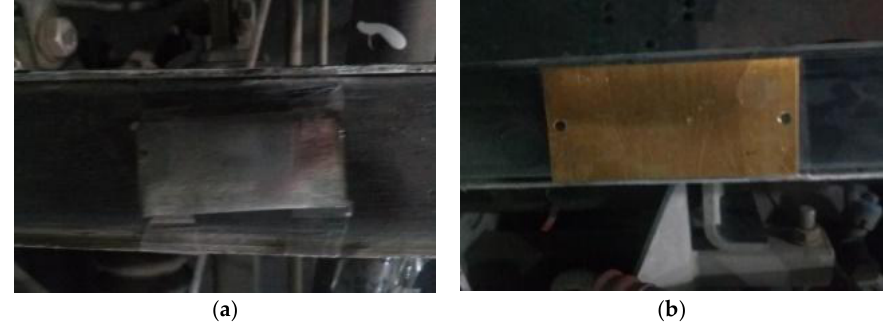
Figure 10. ( a )Measured Object 1; ( b ) Measured Object 2.